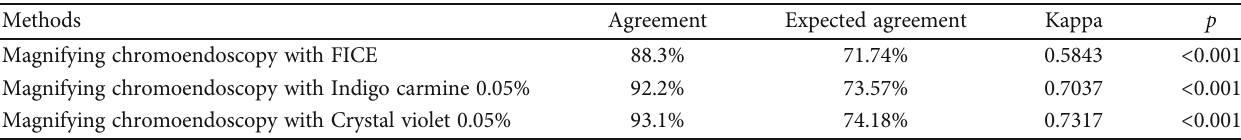
Table 6: The agreement of di ff erential diagnostic value of neoplastic and nonneoplastic polyps of magnifying chromoendoscopy with histological